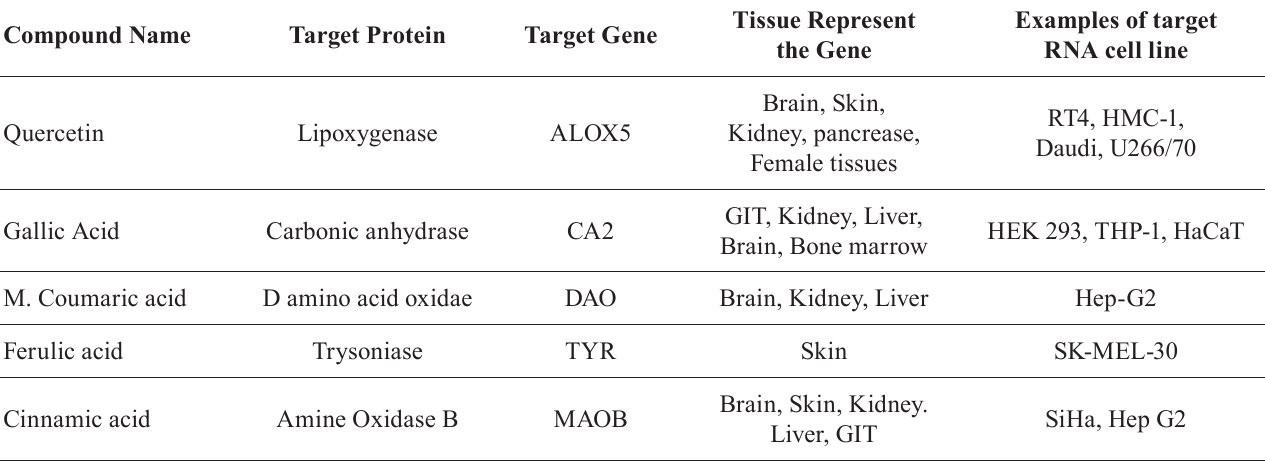
TABLE II - Network pharmacology results predicting potential